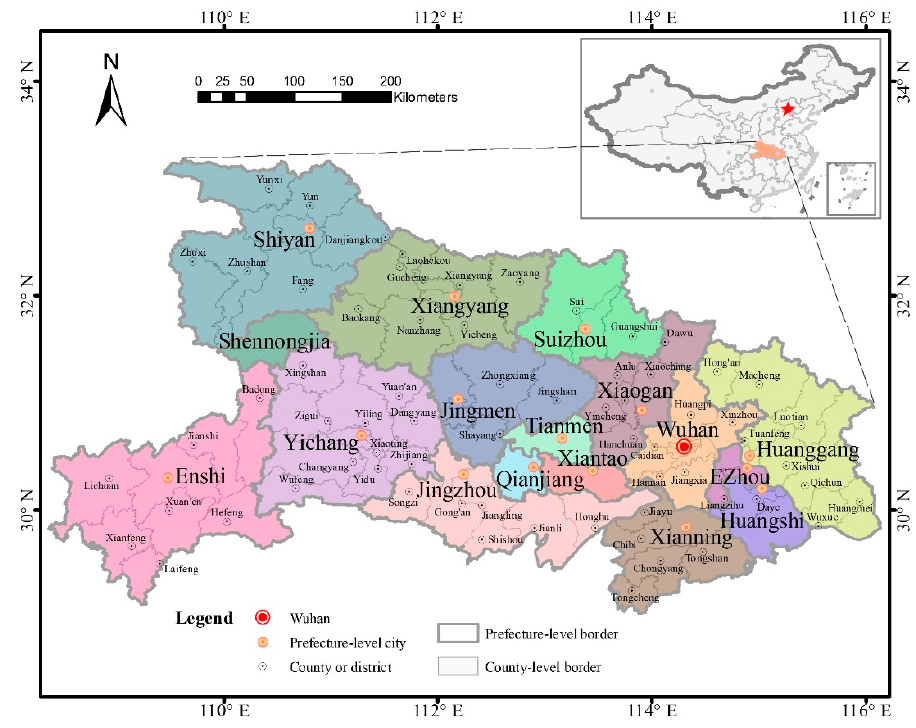
Figure 1. Sketch map of the research area.